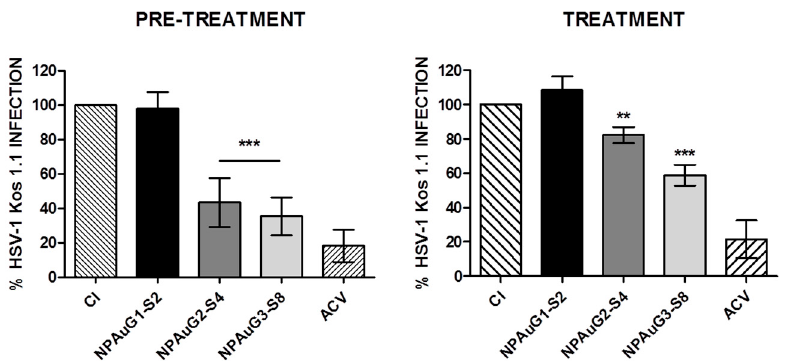
Figure 3. Inhibition of HSV-1 infection by NPAus in SK-N-MC cell lines. SK-N-MC cell line was exposed to the maximum non-toxic concentration of each NPAus and HSV-1 infected at MOI 1 for 24 h in pre-treatment assay or 1h in treatment assay. 20 µ M ACV was used as a positive control of HSV-1 inhibition. Data represent mean ± SD from at least three independent experiments performed by duplicate. *: p < 0.05; **: p < 0.01; ***: p < 0.001. CI: HSV-1 infection at MOI 1.